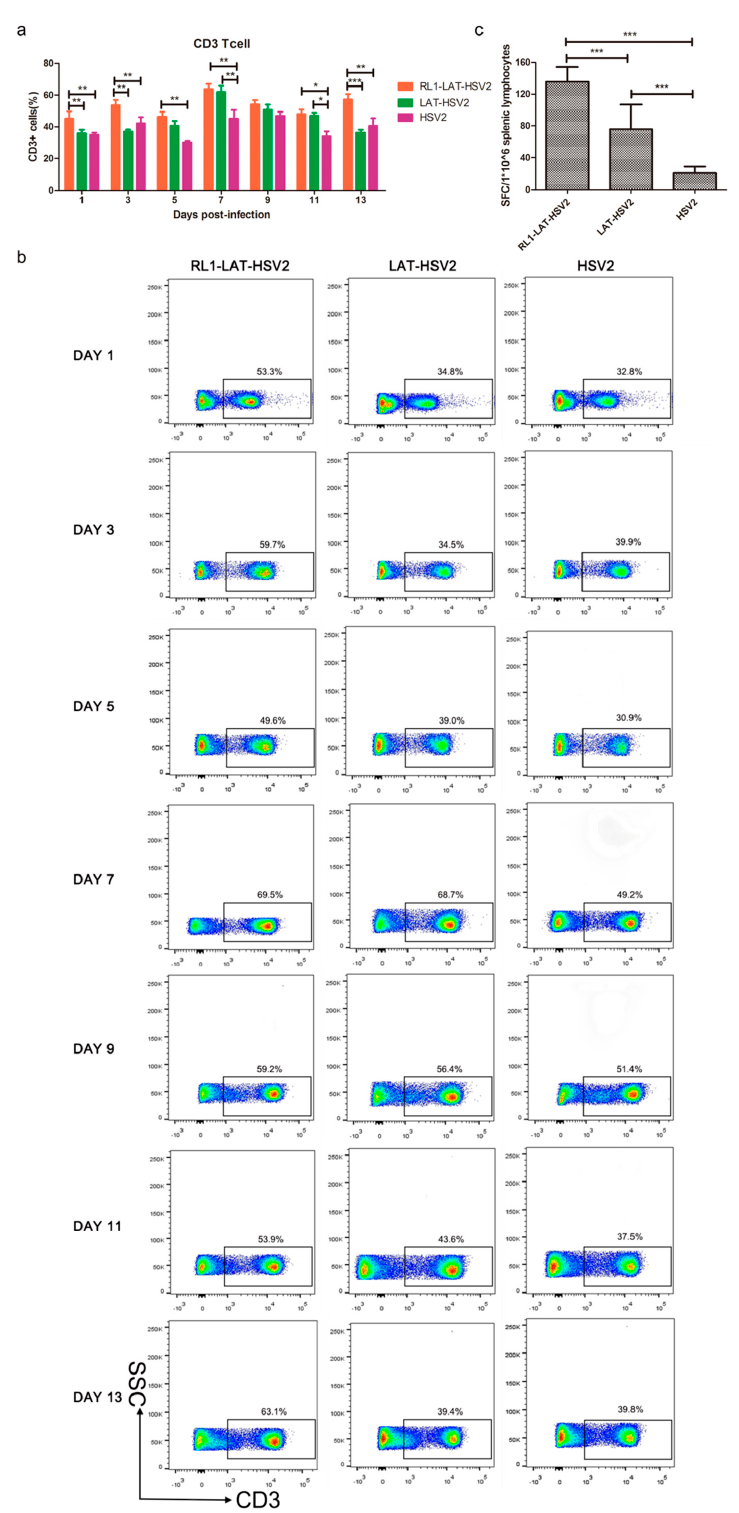
Figure 5. RL1-LAT -HSV-2 induces an increased specific immune response. ( a ) Statistics regarding the number of T cells among splenic lymphocyte cells in infected mice subjected to vaginal challenge. ( b ) T